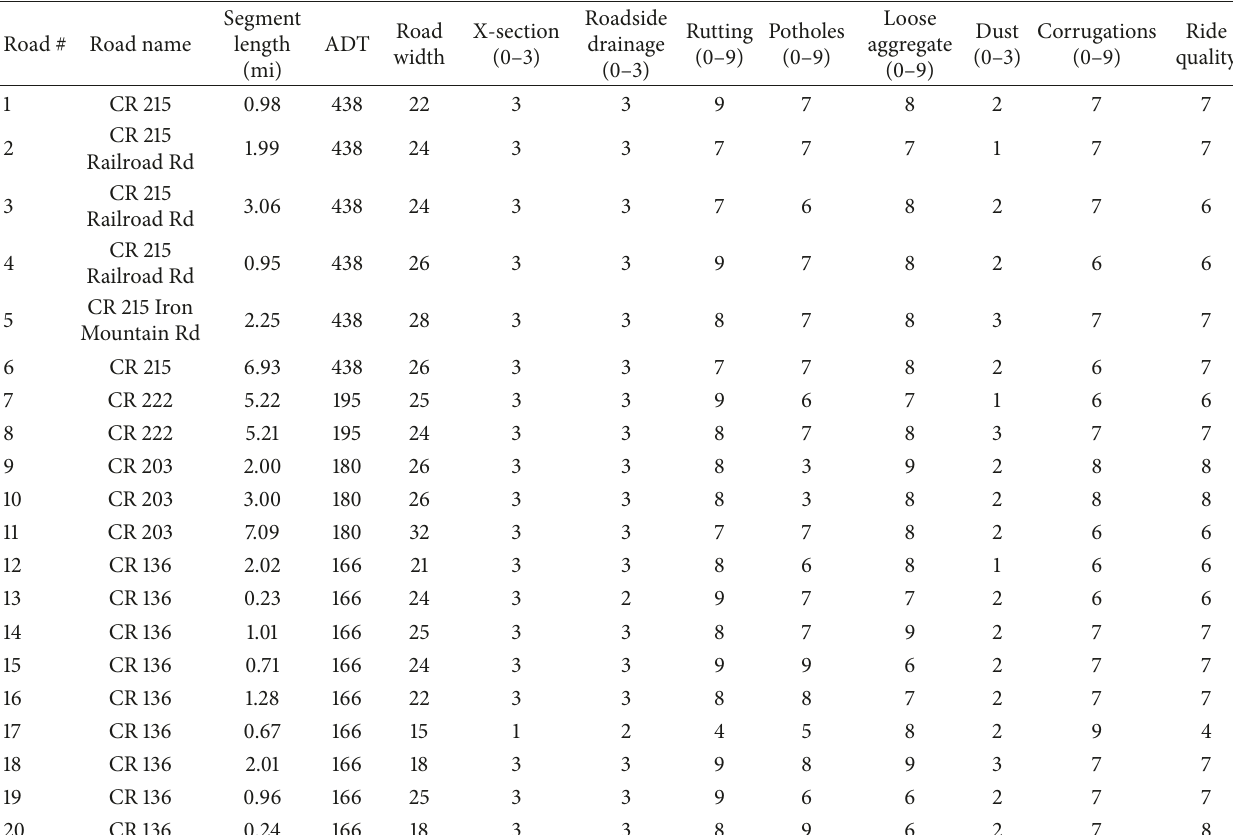
Table 4: Road conditions of county unpaved